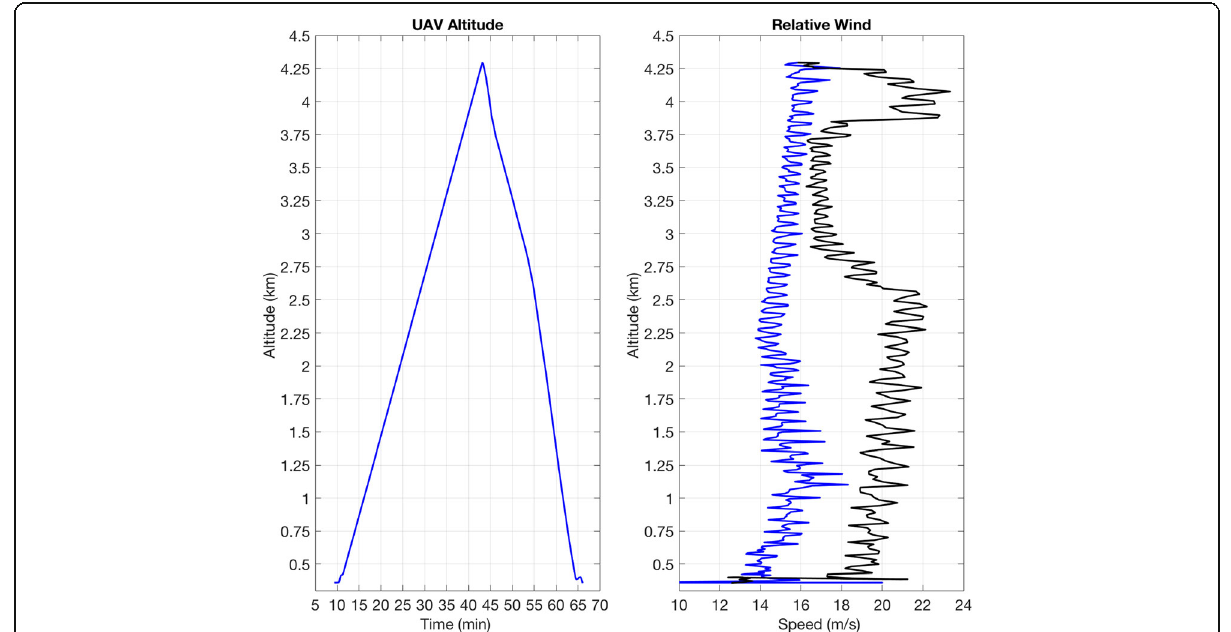
Fig. 11 ( Left panel ) Altitude of the UAV for flight UAV 5 as a function of time. ( Right panel ) Speed of the UAV relative to the ambient air. Ascent is shown in blue and descent in